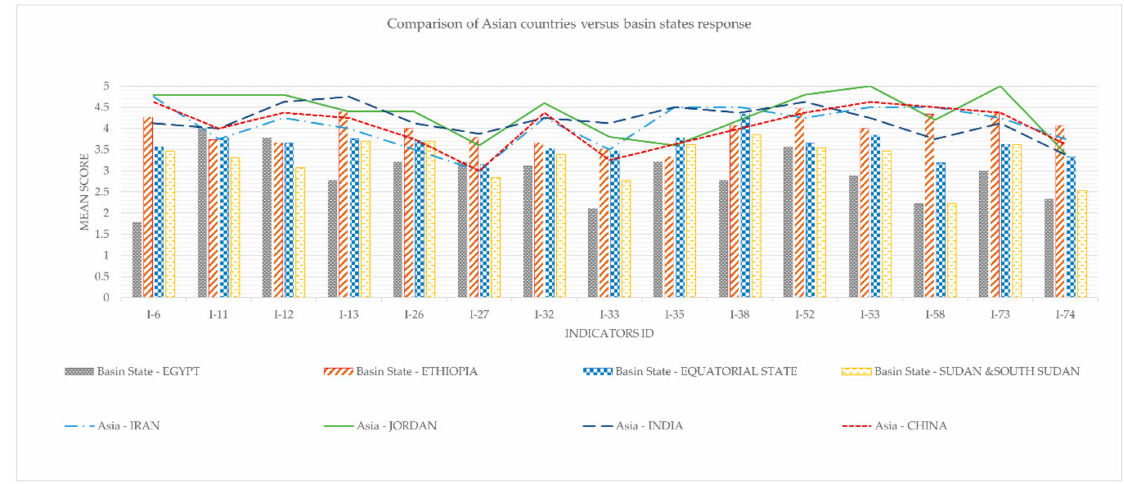
Figure A4. The response of Arab league and middle east countries as compared to basin states